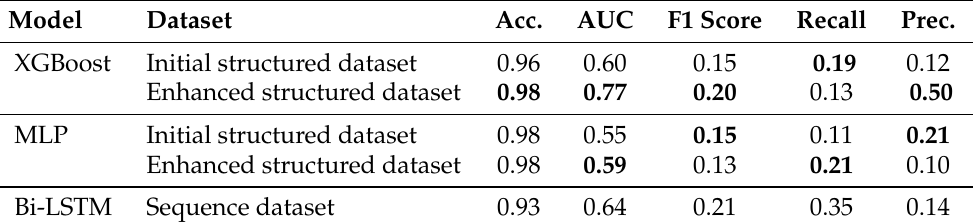
Table 3. Performance measures (predicting death). Considering patients that die as positive sam- ples, we report performance as in the previous Table (for confusion matrices see Additional file